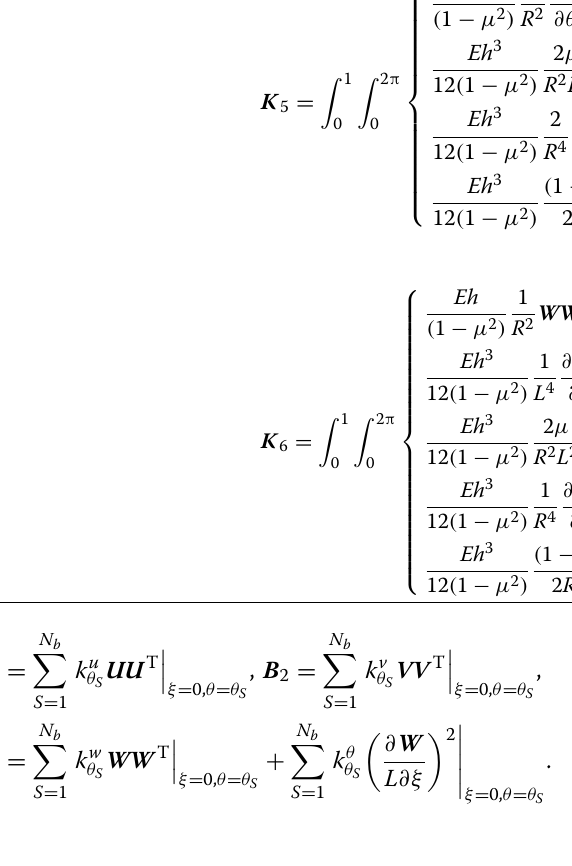
Table 1 The geometric and material properties of the cylindrical